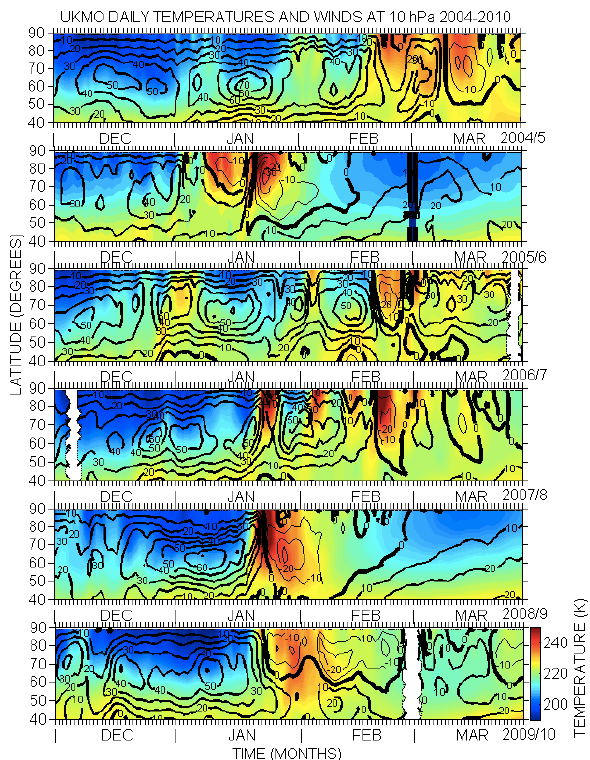
Fig. 12. Daily UKMO temperatures for the major SSW’s in the Northern Hemisphere winters of 2004/2005 to 2009/2010. Also plotted are the UKMO daily zonal winds (ms − 1 ) as contour lines.